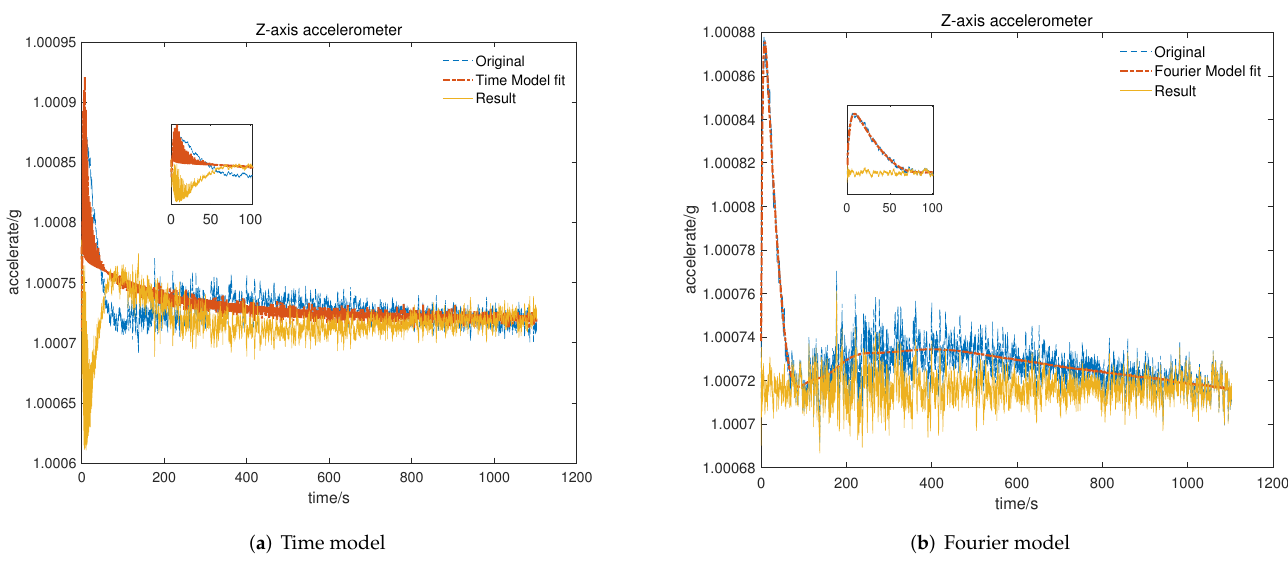
Figure 9. Result of temperature compensation for Z -axis accelerometer: ( a ) compensation with time-related model; ( b ) compensation with Fourier-related